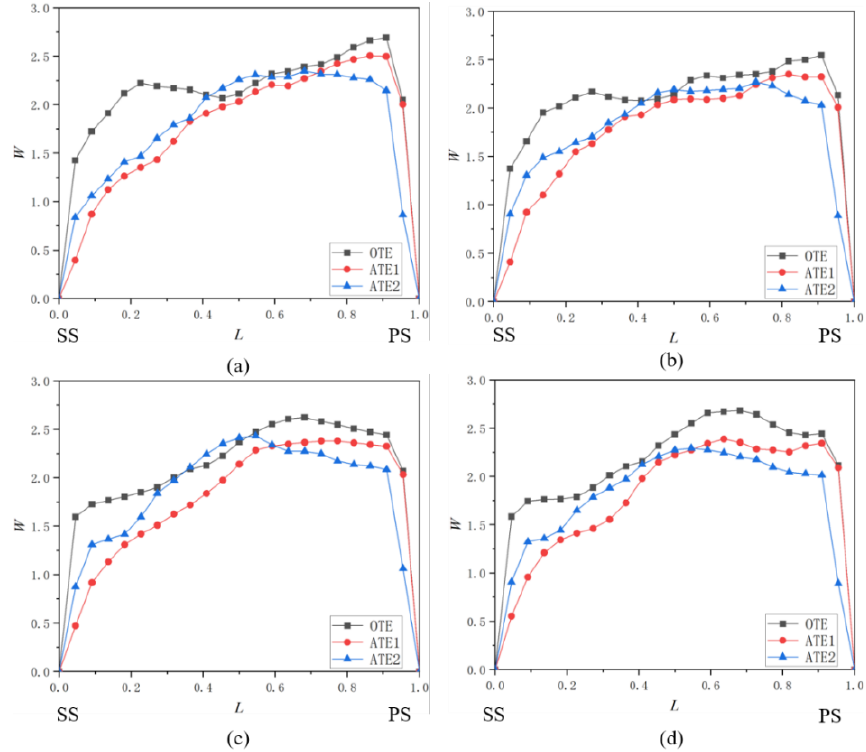
Figure 9. Blade-to-blade distributions of the relative velocities at R/R 0 = 1.0: ( a ) 0.2 Q BEP ; ( b ) 0.4 Q BEP ; ( c ) 1.0 Q BEP ; and ( d ) 1.2 Q BEP .